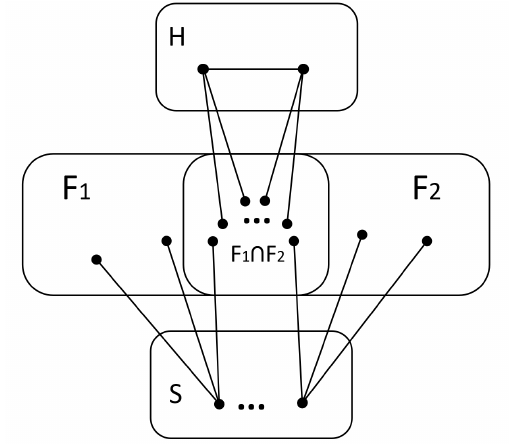
Figure 4. Illustration of F 1 ∩ F 2 is a g-extra vertex